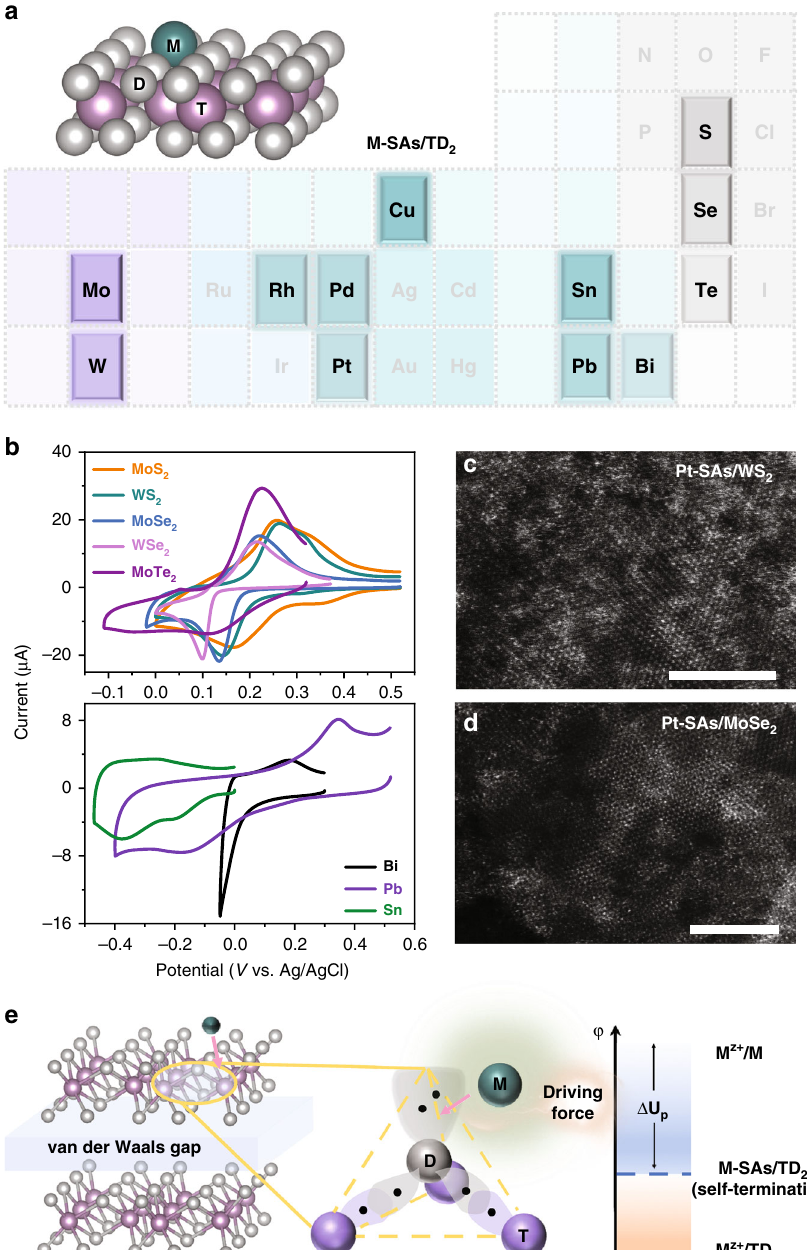
Fig. 3 Generality and mechanism of SSED. a A library of ADMCs synthesized on TMDs. b Cyclic voltammograms of UPD of Cu on different TMDs (top) and of UPD of different metals on ce-MoS 2 nanosheets (bottom). c , d Magni fi ed HAADF-STEM image of Pt-SAs/WS 2 and Pt-SAs/MoSe 2 (scale bars: 5 nm). e Mechanism of SSED growth for ADMCs on TMDs. M represents the deposited single-atom metal; TD 2 represents the TMD